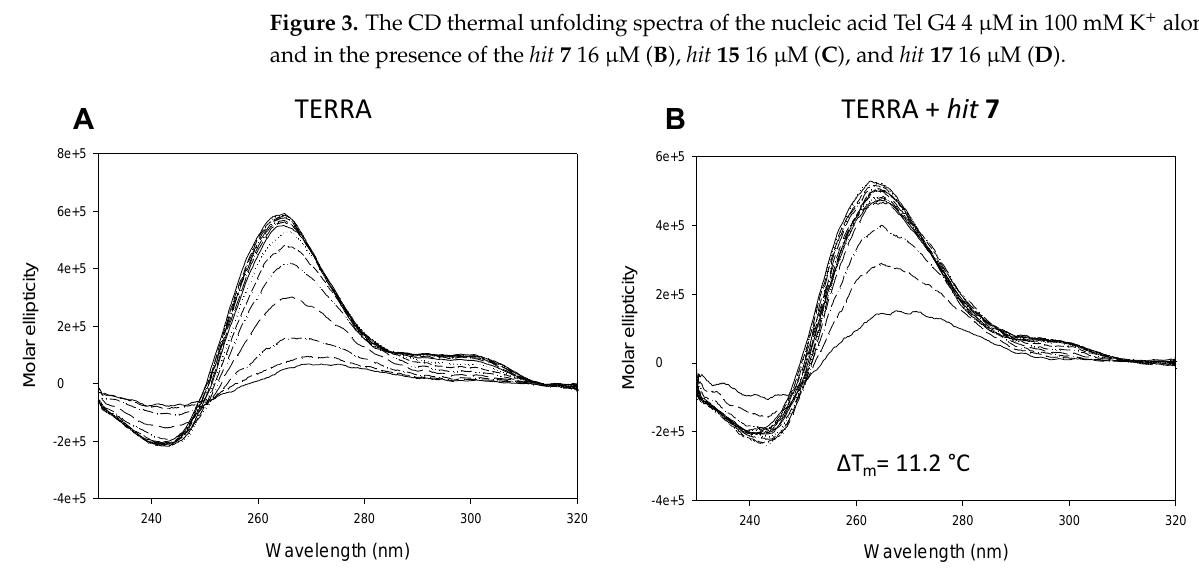
Figure 4. The CD thermal unfolding spectra of the nucleic acid TERRA G4 4 μM in 100 mM K + alone ( A ) and in the presence of hit 7 16 μM ( B ), hit 15 16 μM ( C ), and hit 17 16 μM ( D ). To measure the binding affinity of the hits to the G4-folded oligonucleotides with unmodified 5′ - and 3′ -ends (i.e., lacking fluorophores or biotin), we employed ESI-MS analysis, as previously described [40]. All hits displayed both a 1:1 and 1:2 binding ratio, albeit adducts with 2 bound hit molecules were 2 – 3 times less abundant than those with 1 bound hit molecule. For each hit , the binding affinity (K D ) of the 1:1 complex with Tel and TERRA G4s was measured at three compound concentrations, corresponding to 1:1, 1:2, and 1:4 G4:compound ratios. K D values were 3.4 ± 0.2 μM, 7.1 ± 1.2 μM , and 6.1 ± 0.2 μM for binding of hits 7 , 15, and 17 , respectively, to TERRA G4 (Figures 5 and S11). Binding affinity to Tel G4 was in general lower, with K D values of 11.0 ± 0.7 μM, 18.0 ± 4.2 μM , and 22.9 ± 6.4 μM for binding of hits 7 , 15, and 17 , respectively (Figure S10).